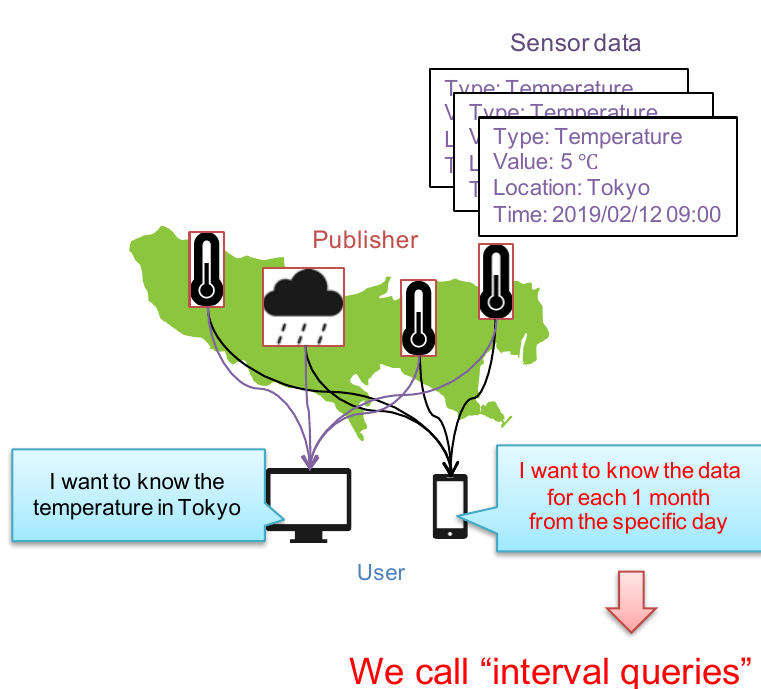
Figure 1. Users’ queries which request data with the specific time